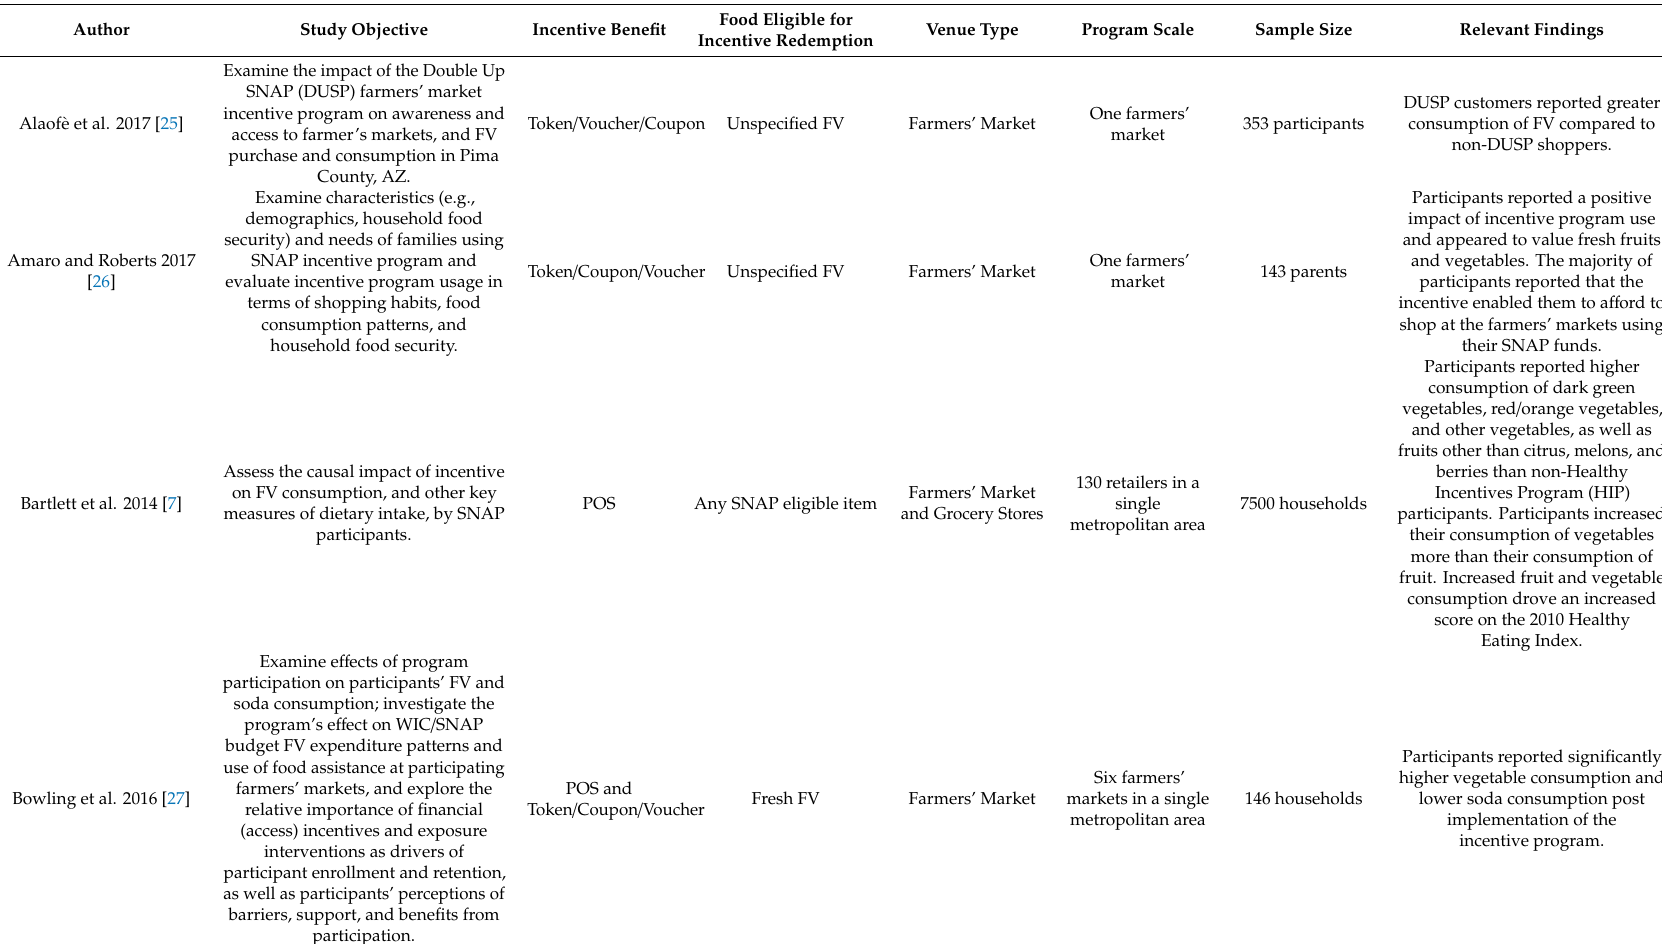
Table 1. Summary of studies on fruit and vegetable incentives as an approach for encouraging and enabling Supplemental Nutrition Assistance Program (SNAP) participants in the United States to increase the purchase and / or consumption of healthy